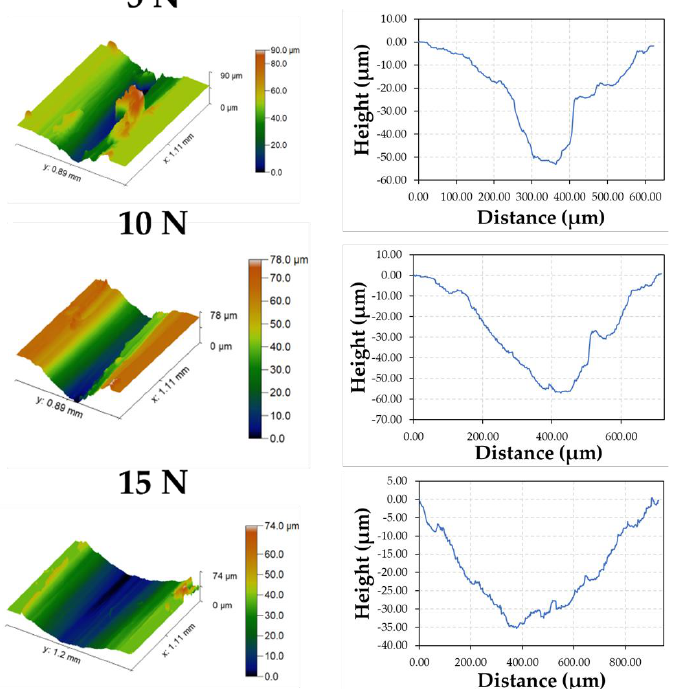
Figure 14. The wear tracks of the bare Al6061 plate under the normal loads of 5, 10, and 15 N.